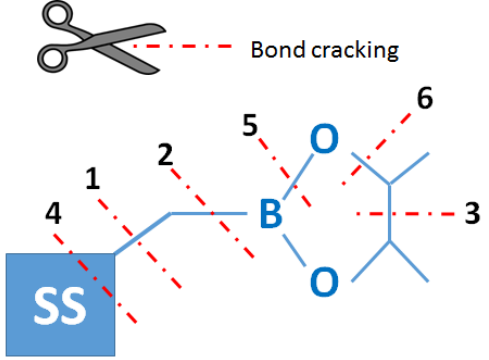
Figure 4. Probability of bonds ’ scission based on their energy (based on the energy of a single bond — stabilization effects were not taken into account). Table 1. Bond energy (according to reference [42]).